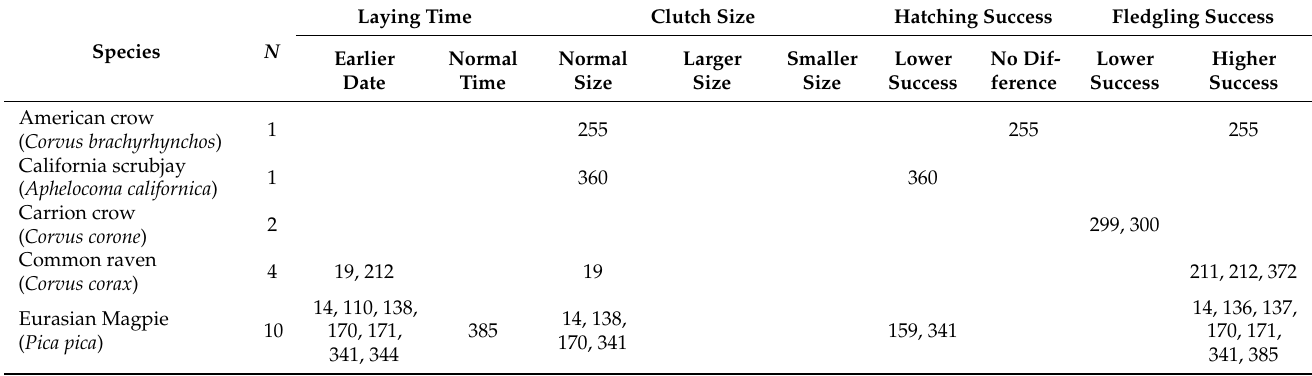
Table 8. Number of articles reporting differences between urban and rural areas in egg-laying date, clutch size, hatching success and fledging success in ten corvid species ( n = 31). The reference numbers in the table refer to the individual publication numbers given in Table